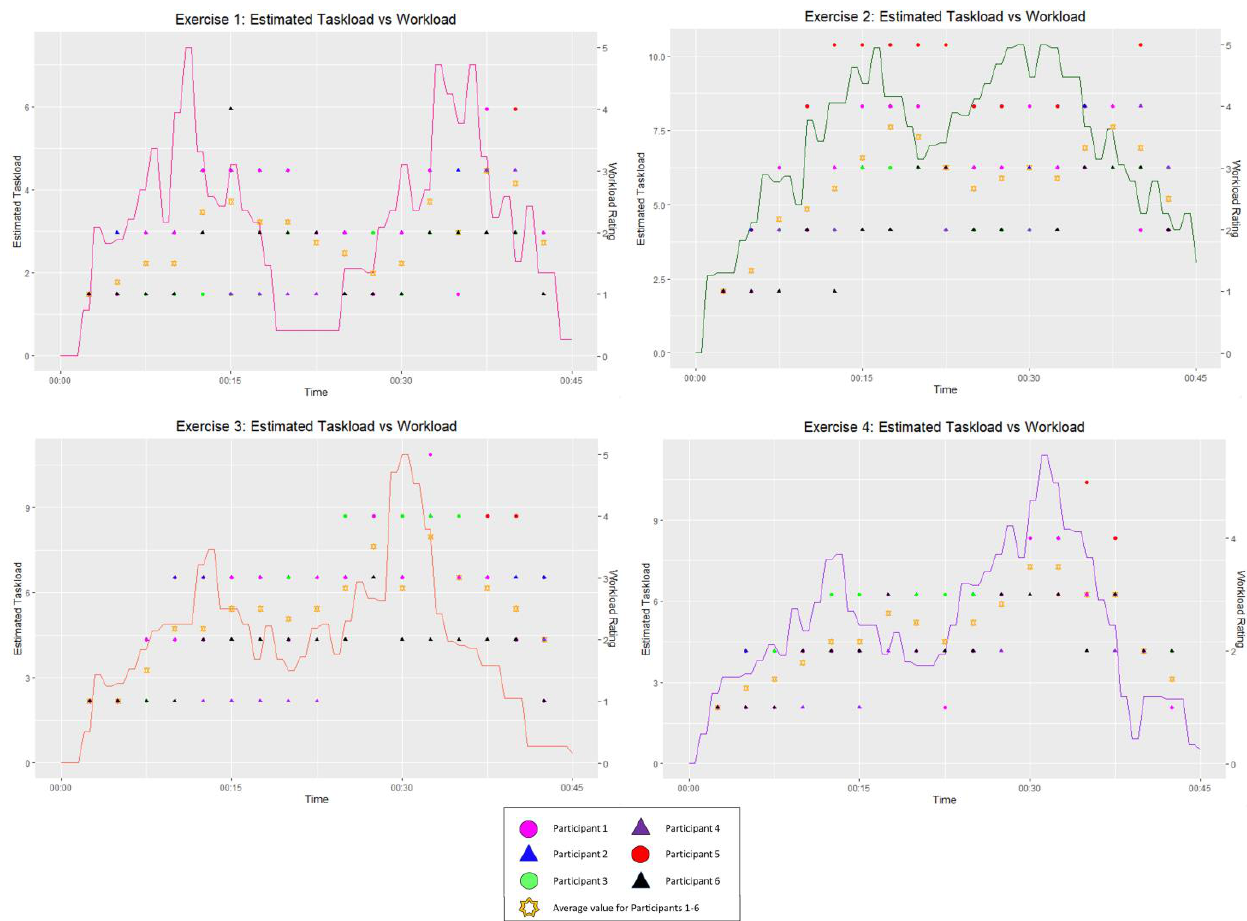
Figure 4. Combined representation of the designed taskload profile of the exercises together with subjective workload assessments for the six participants. The first row of graphs presents Exercise 1 on the left and Exercise 2 on the right. The second row presents the data from Exercise 3 on the left and Exercise 4 on the right.